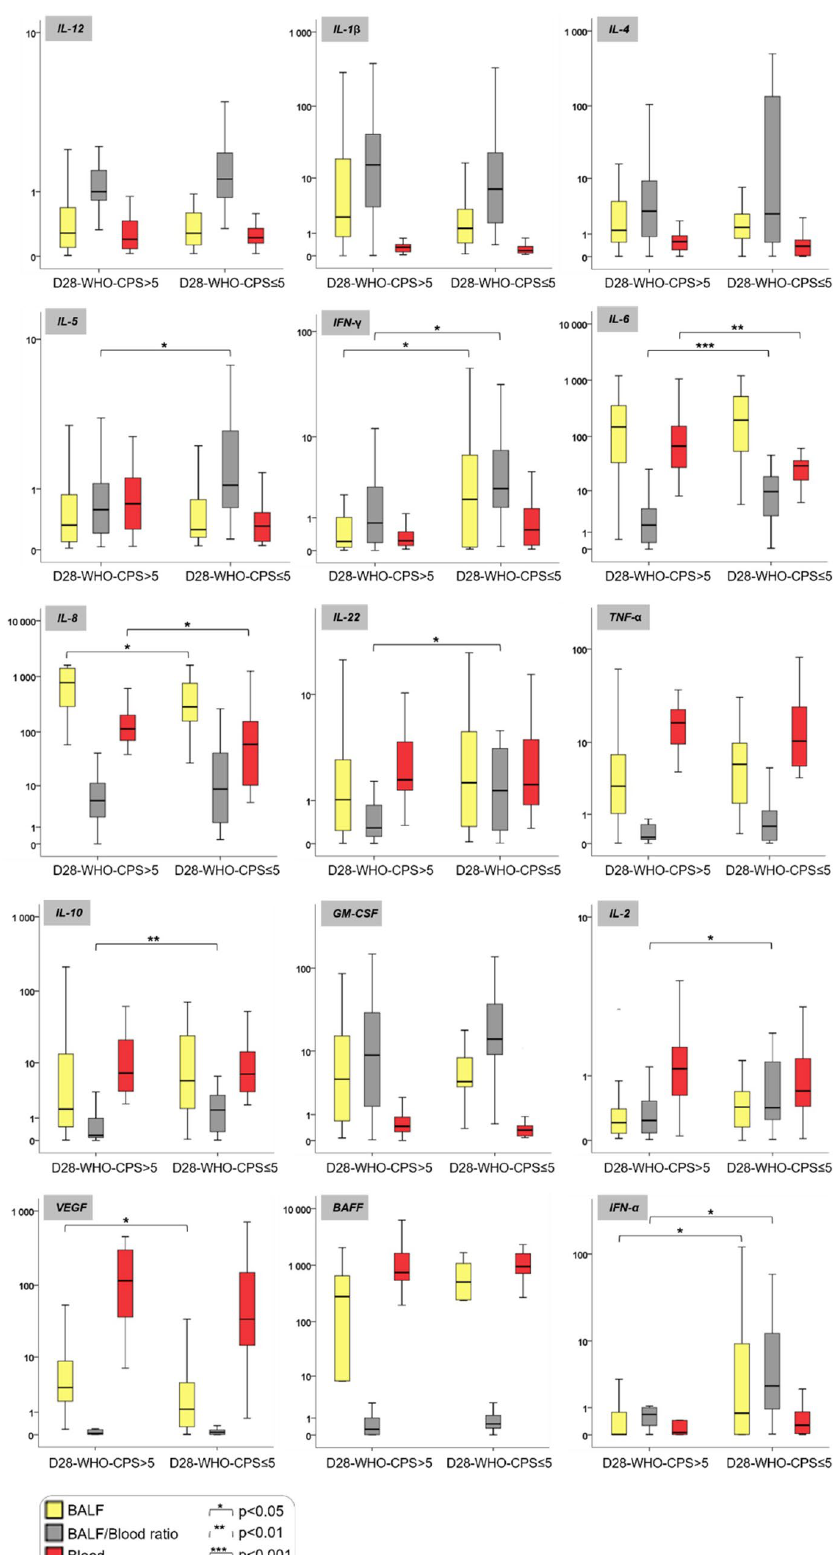
Figure 3. Cytokine profiling of blood and bronchoalveolar lavage fluid in critically ill COVID-19 patients, according to the 28-day WHO-CPS. Data are presented as box and whiskers plots (N = 26–32 per group). Patients were grouped according to the World Health Organization 10-point Clinical Progression Scale (WHO-CPS) at 28-day. A score value higher than 5 (D28-WHO-CPS > 5) defined a poor 28-day outcome, whereas a score value equal or lower than 5 (D28-WHO-CPS ≤ 5) defined a good 28-day outcome. Groups were compared using the non-parametric Mann–Whitney test for bronchoalveolar lavage fluid (BALF) concentrations, BALF/blood ratio of concentrations and blood concentrations of each cytokine. All the concentrations are expressed in